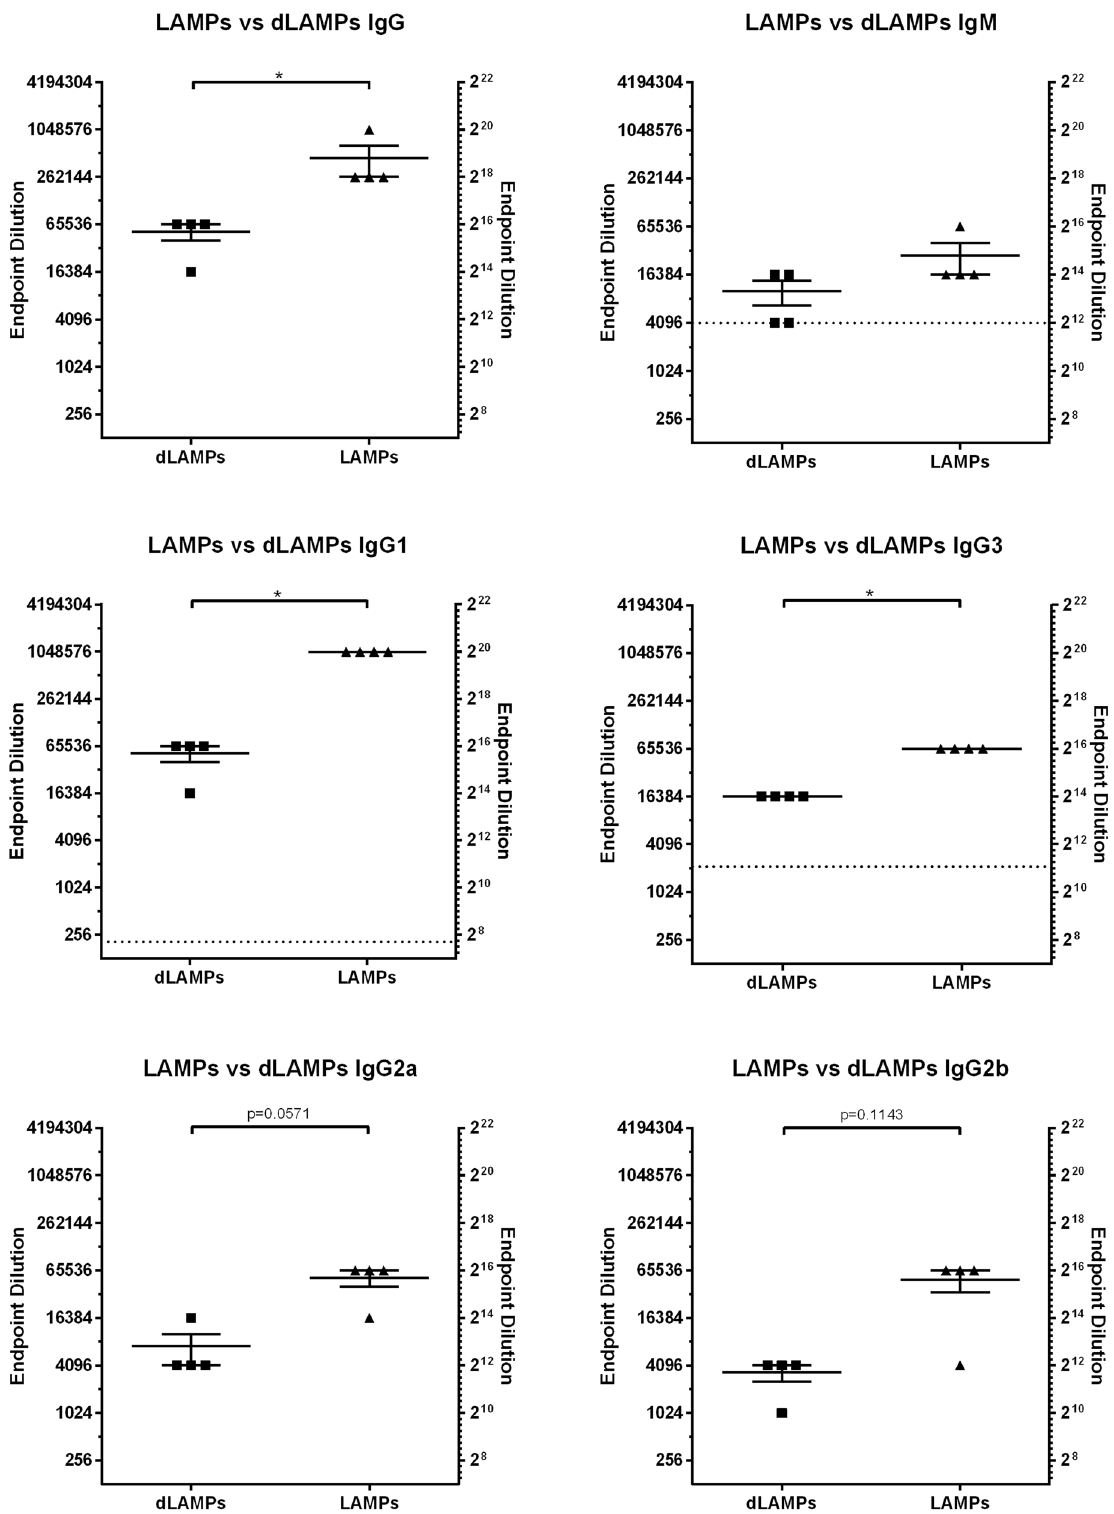
Fig. 1 Serum antibody responses to Lipid-associated Membrane Proteins (LAMPs) or delipidated Lipid-associated Membrane Proteins (dLAMPs) in vaccinated mice. Endpoint titers are displayed as the reciprocal of the fi nal dilution at which signal was at least three times greater than the assay background. Data were analyzed by Mann – Whitney Test. Data were considered signi fi cant for p < 0.05. Data without signi fi cance marking is to be considered not signi fi cantly different. Dotted line indicates the lower limit of detection of the